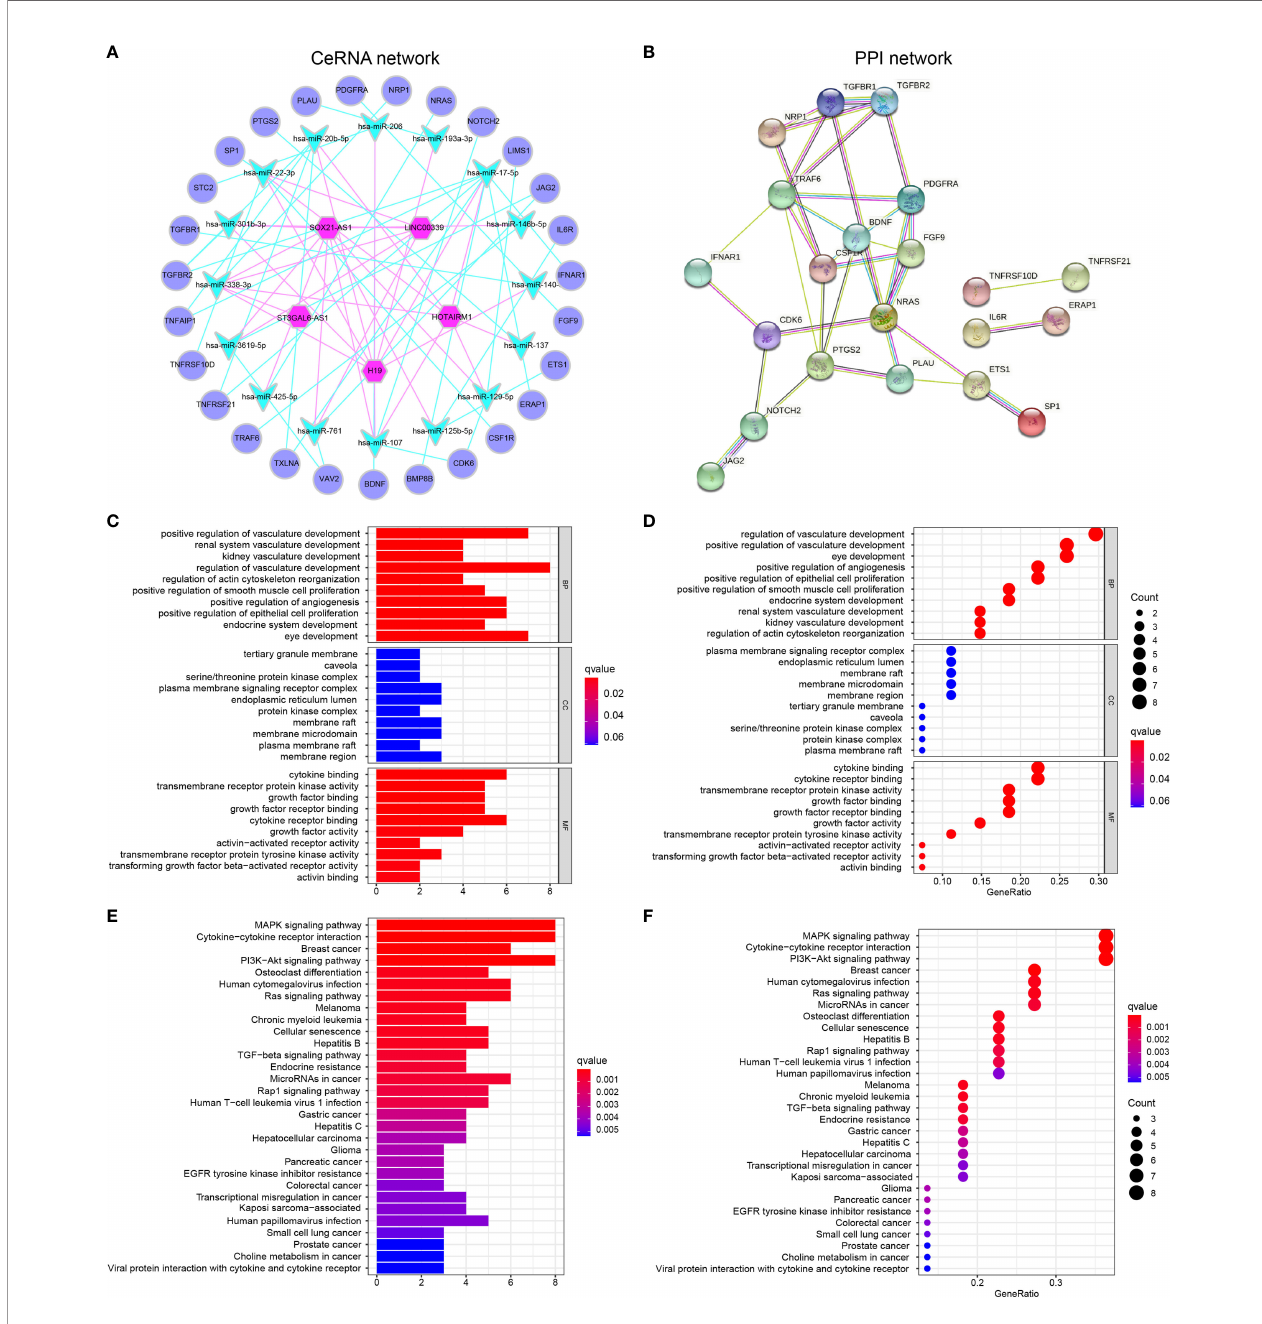
FIGURE 3 | GBM-speci fi c CeRNA network, PPI network, and functional enrichment analysis (A) A total of 31 irlncRNAs – miRNA interactions and 35 miRNA – DEIGs interactions construct the lncRNA – miRNA – mRNA regulatory networks. (B) PPI network displayed the interactions of proteins translated from IGs in the CeRNA network. (C, D) GO enrichment analysis (E, F) KEGG pathway enrichment